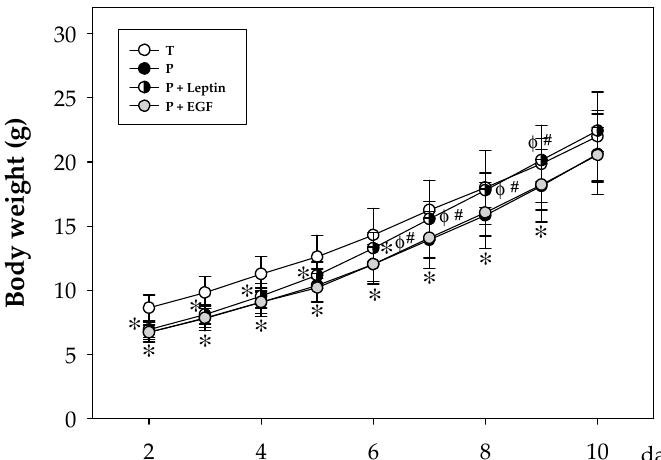
Figure 1. Body weight from the four groups: Term (T), Preterm (P), P + Leptin, and P + epidermal growth factor (P + EGF) the first 10 days of the study. Results are expressed as mean ± SD ( n = 12–30 pups/group). Statistical differences: * p < 0.05 versus T group; φ p < 0.05 versus P group; # p < 0.05 versus P + EGF group. Table 1. Morphometric variables and relative organ weights or lengths from Term (T), Preterm (P), P + Leptin, and P + epidermal growth factor (P + EGF) groups at days 10 and 17.